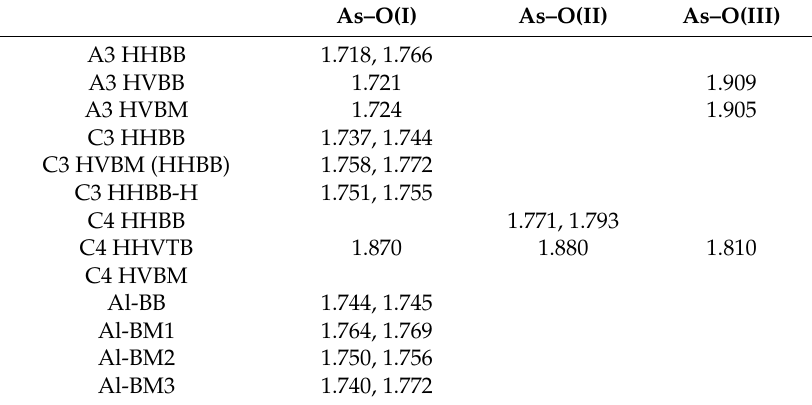
Table 2. As–O surf bond distances in Å for the model sorption structures. O(I), O(II) and O(III) refer to singly-, doubly- and triply-coordinated surface oxygen, respectively. Two As–O surf bond distances are reported for each bidentate structure, and three are reported for the tridentate